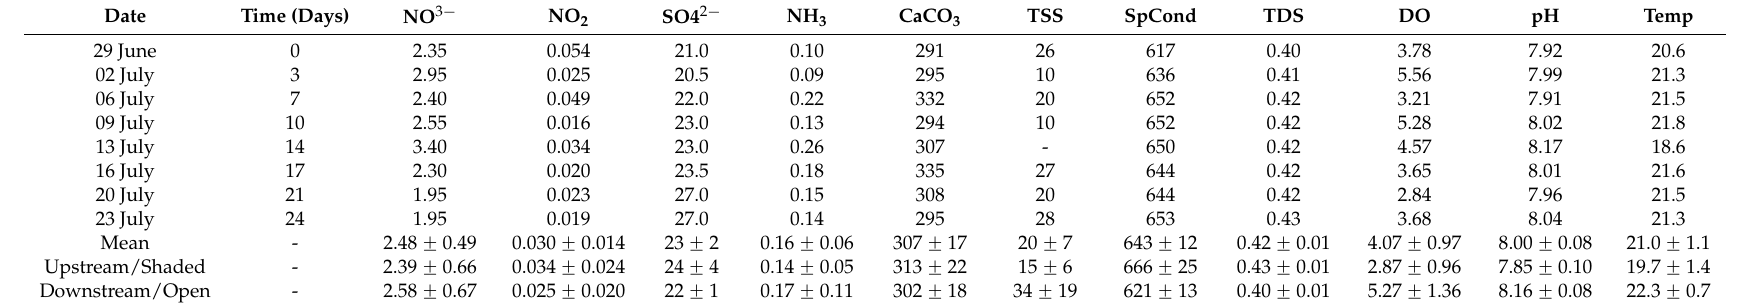
Table 1. Water quality parameters in Farmersville, OH, USA were measured when substrates were deployed and at every sampling date 15 m above and below the uppermost and lowermost carcasses, respectively. Nitrate (mg/L NO 3 ´ -N), nitrite (mg/L NO 2 ´ -N), sulfate (SO4 2 ´ mg/L), ammonia (mg/L NH 3 -N), alkalinity (mg/L CaCO 3 ), and total suspended solids (TSS mg/L) were measured in the lab using EPA approved protocols (Hach ® Company, Loveland, CO, USA). Specific conductivity (SpCond µ S/cm), total dissolved solids (TDS mg/L), dissolved oxygen (DO mg/L), pH, and temperature ( ˝ C) were recorded using an YSI 6600 v2 Sonde (YSI Inc., Yellow Springs, OH, USA). Bolded means denote significant differences ( p < 0.05) between the upstream and downstream sites using a two tailed t